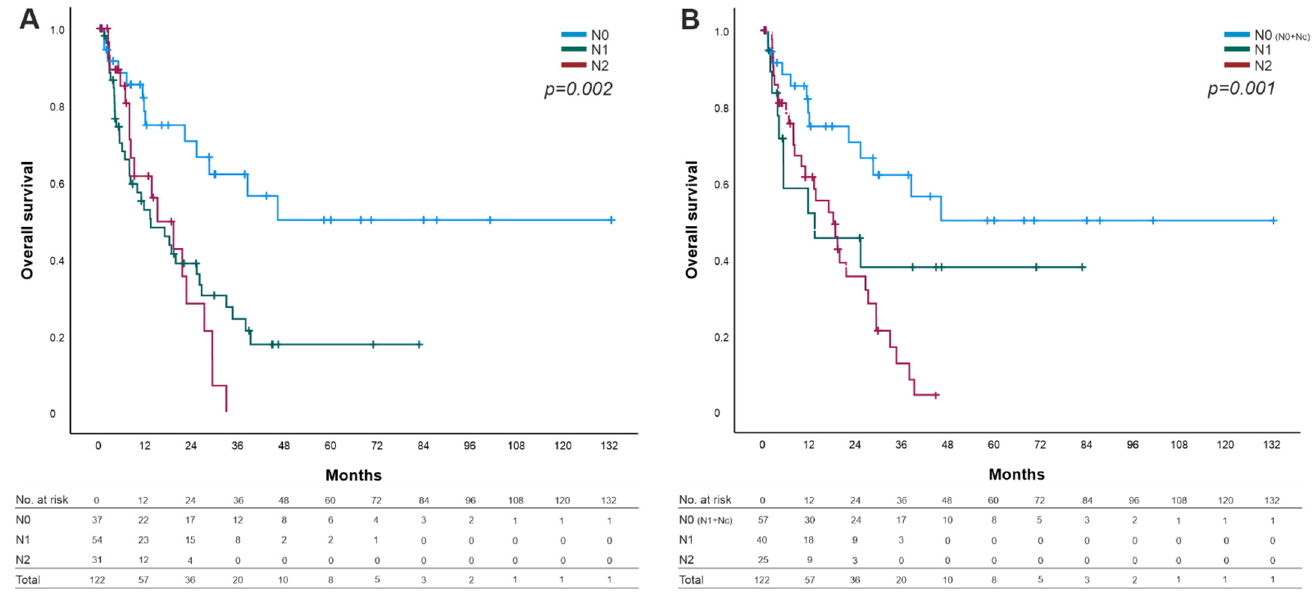
Figure 3. Overall survival (OS) sorted by N categories. ( A ) OS of the 8th edition of the AJCC Cancer Staging Manual for PDAC. ( B ) Revised N categories (N0-R = N0 + Nc) with statistically significant difference compared with the actual N categories ( p = 0.002 vs. p = 0.001).